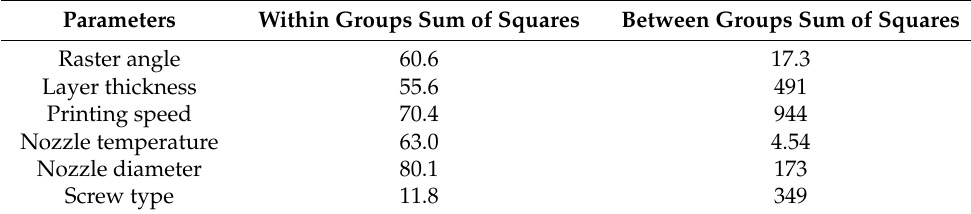
Table 2. Data from one-way ANOVA.